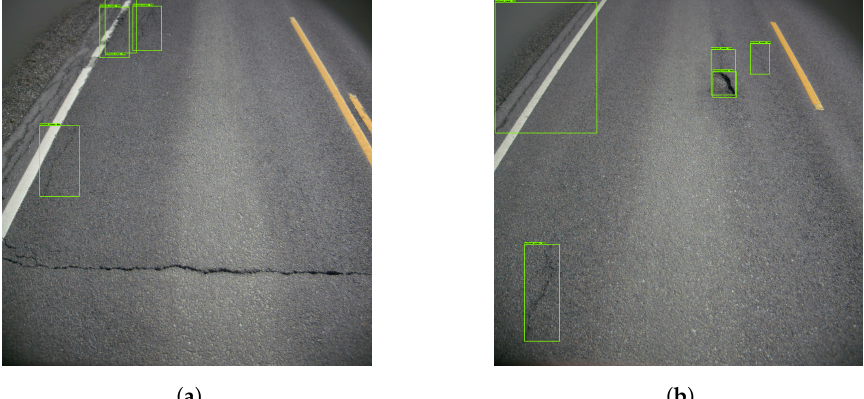
Figure 6. Examples of missed cracks. The green boxes represents the vertical